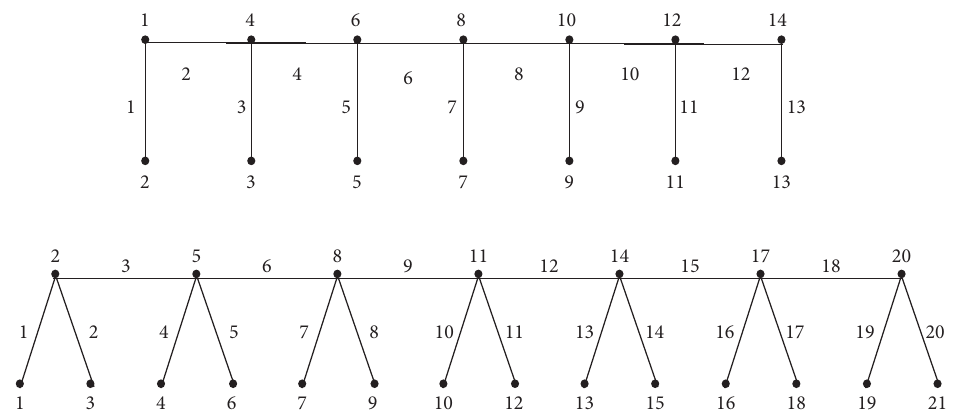
Figure 3: A classical mean labeling of P